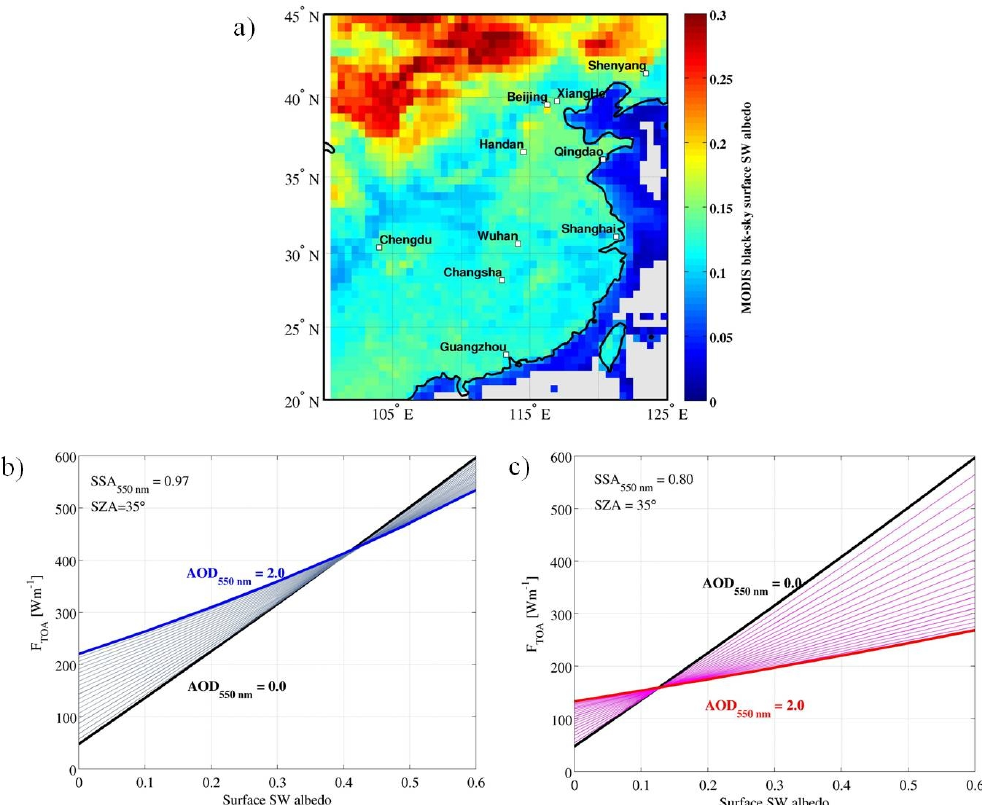
Figure 3. Monthly mean (September 2009) of the shortwave black-sky broadband albedo obtained from the MODIS MCD43C3 data (a) , and radiative transfer simulations of TOA SW fluxes as a function of surface albedo and varying aerosol loading for highly scattering (b) and absorbing (c) aerosol